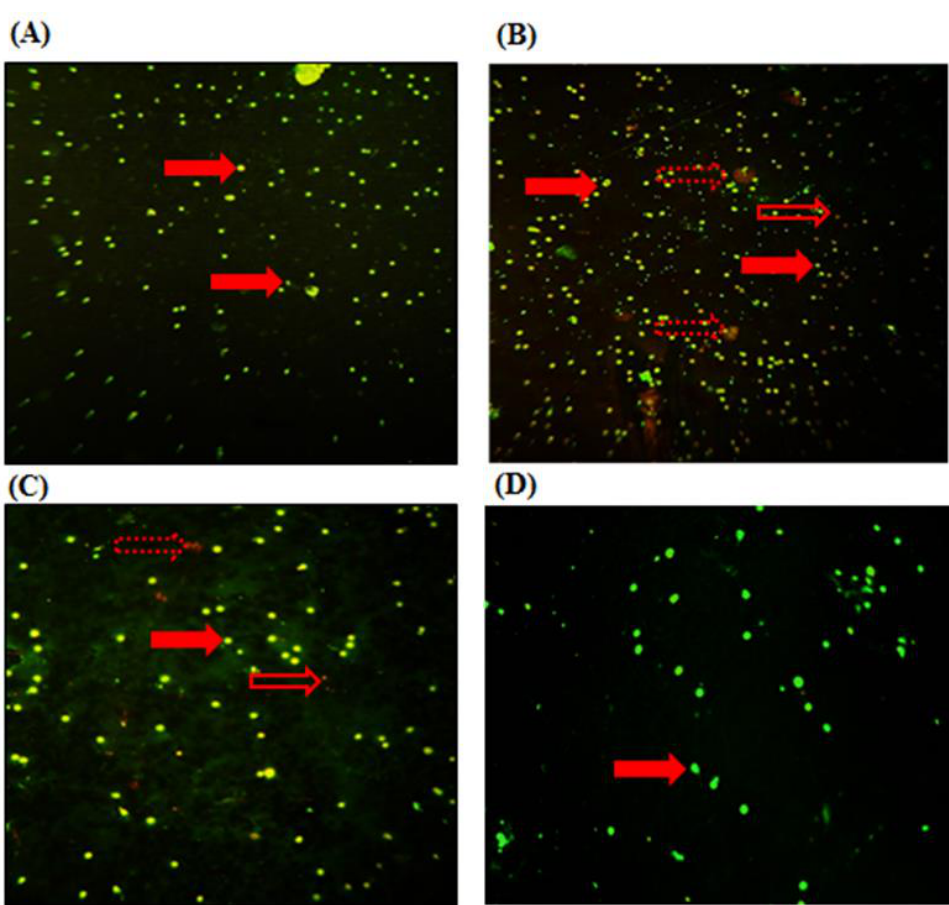
Figure 4. Micronucleus test of controls and treated rats for 7 days with MT, and MT co-administrated with alga. ( A ) Control group; ( B ) rats treated with MT; ( C ) rats treated with MT + FRE; ( D ) rats treated with FRE. Arrows indicate the following: nucleus of WBC; necrotic cells; apoptotic cells.